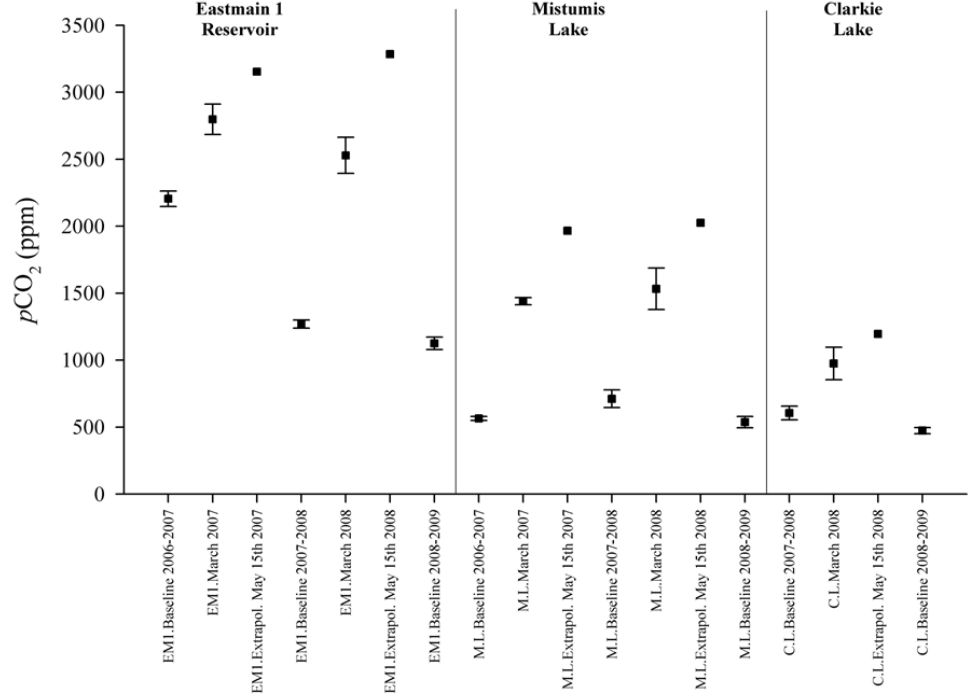
Fig. 5. Measured and extrapolated partial pressure of CO 2 for different systems studied. Bars represent standard errors. Baseline points Figure 5. Measured and extrapolated partial pressure of CO represent mean values during ice-free Bars represent standard errors. Baseline points represent mean values during ice-free periods.